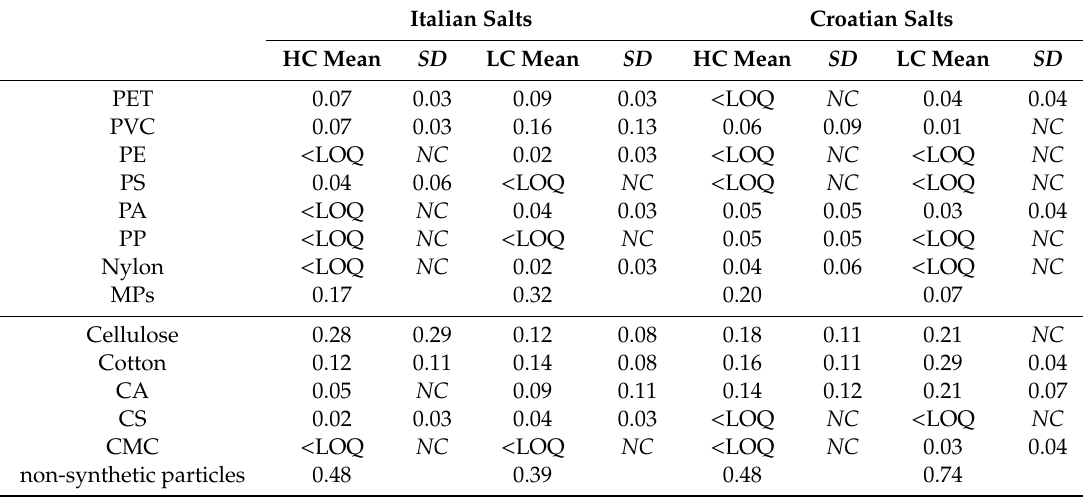
Table 2. MPs and non-synthetic particles (total average amount and chemical composition)